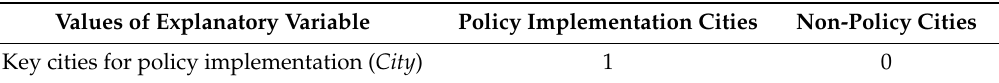
Table 9. The value of the key cities for policy implementation under the time point inspection.